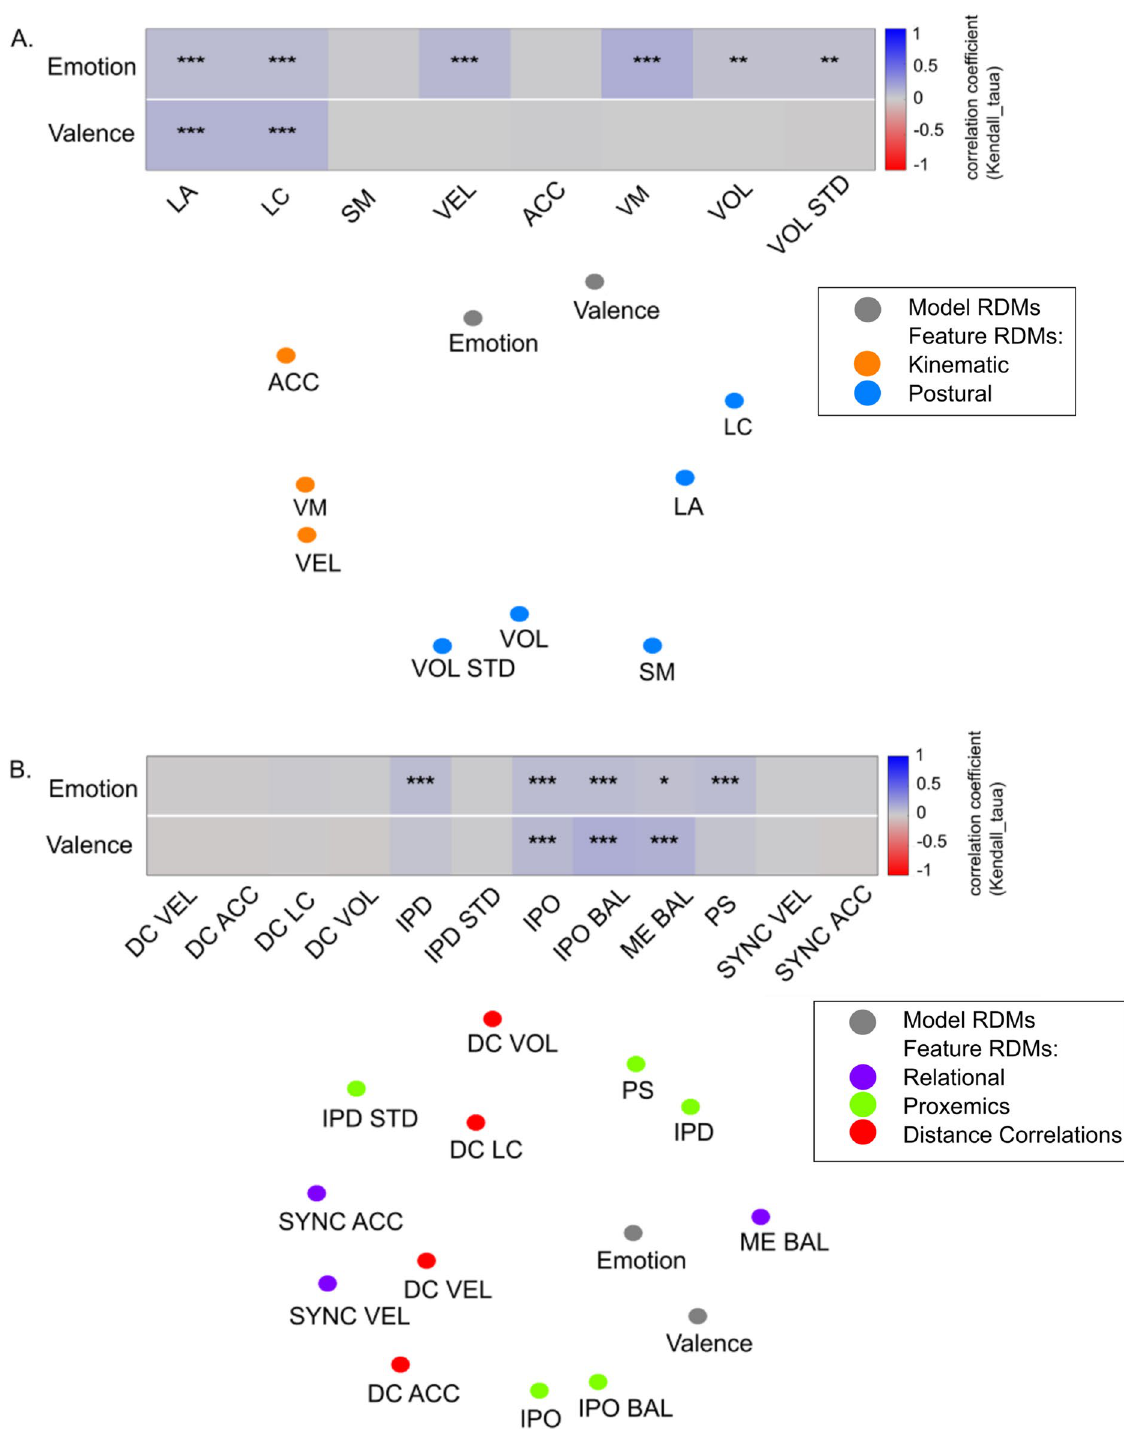
Figure 4. Relationship between model RDMs and feature RDMs for ( A ) intrapersonal features, ( B ) interpersonal features, as indicated by Kendall’s τ A correlation. Significant correlations shown by asterisks ( ns not significant; *p < 0.05; **p < 0.01; ***p < 0.001). MDS plots approximate Kendall’s τ A correlation distance (1 − Kenadll’s τA) among RDMs: the closer the points to each other, the more similar their corresponding